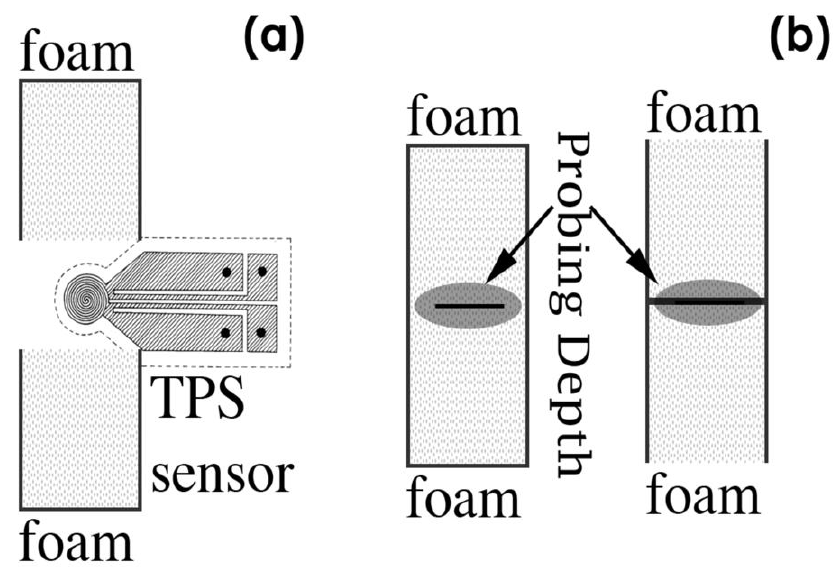
Figure 5. Measurement of the thermal properties of the foams by the TPS method. The TPS sensor is placed between two foams of the same relative density and produced using the same pellets. The sensor heats the foams by a ‘power output’ inside the volume delimited by the ‘probing depth’. For each couple of samples, the experiments were done in two different configurations. ( a ) Measurement in the foam core. ( b ) Measurement performed in the outer bottom surface (skin).